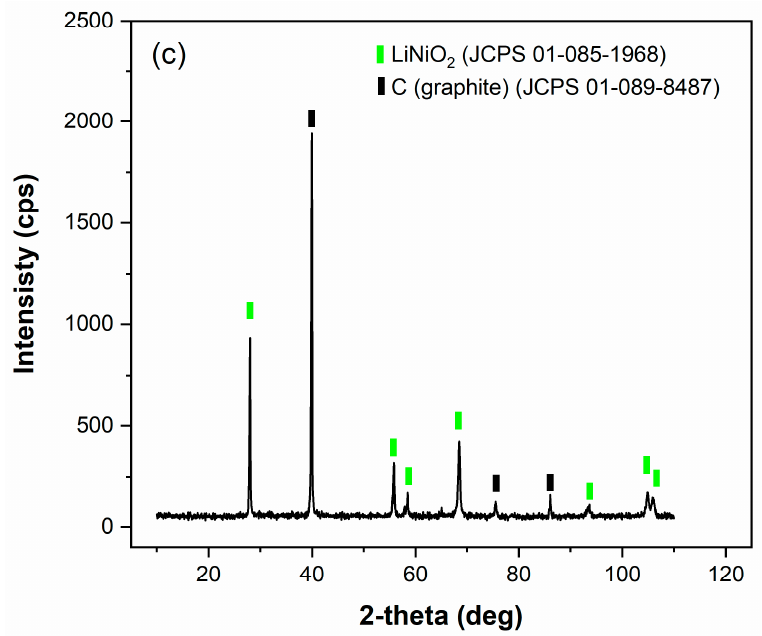
Figure 1. Diffractograms of the black mass samples from spent LIBs: ( a ) SBM, ( b ) VBM-1, and ( c ) VBM-2.